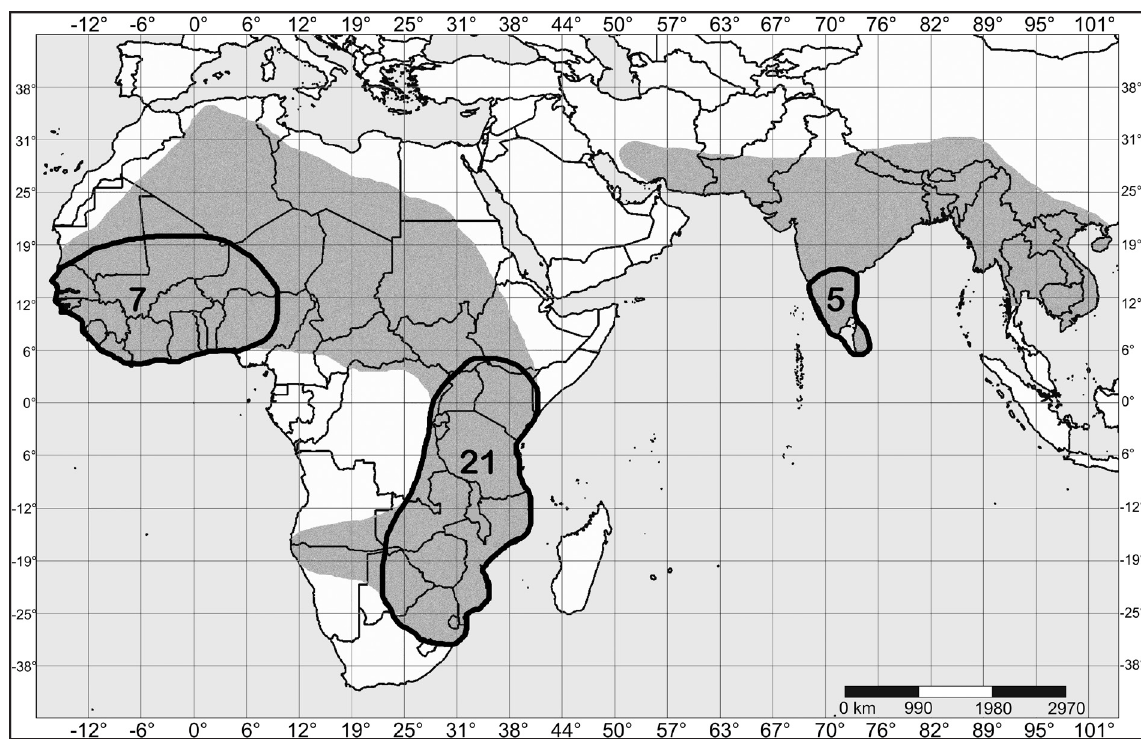
Fig. 507. General distribution and modern centres of species diversity of Stenaelurillus